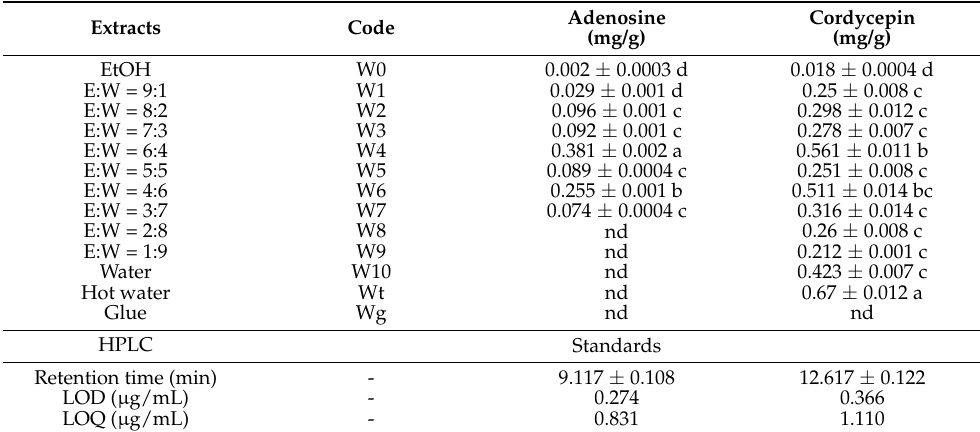
Table 1. Adenosine and cordycepin content in Cordyceps militaris SBRs extracted by different sol- vent systems.